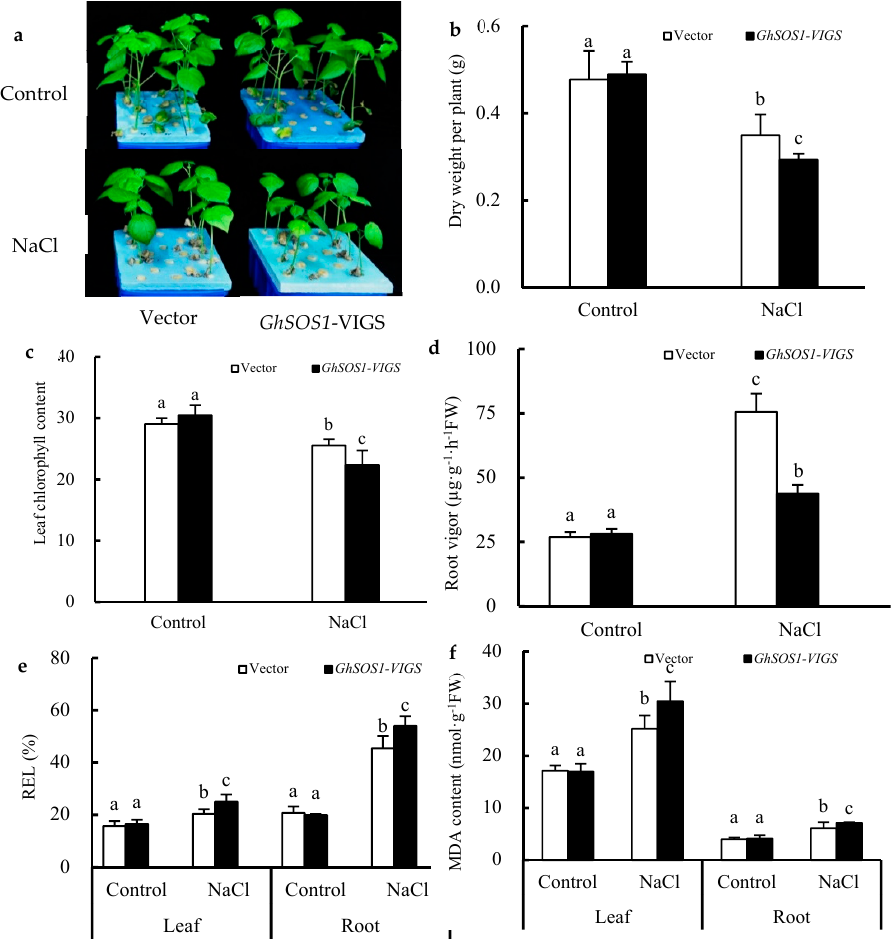
Figure 1. Effects of salt treatment on the growth ( a ), dry weight per plant ( b ), leaf chlorophyll content ( c ), root vigor ( d ), relative electrolytic leakage (REL) value ( e ), and MDA content ( f ) in the leaves and roots of GhSOS1 -VIGS (virus-induced gene silencing) cotton plants. Different lowercases in the same group indicate the significant differences ( p ≤ 0.05).